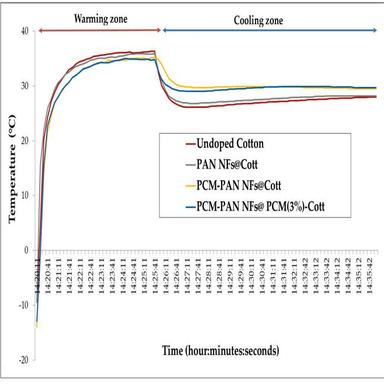
Thermoregulation function of undoped and core-shell structured cotton yarns.